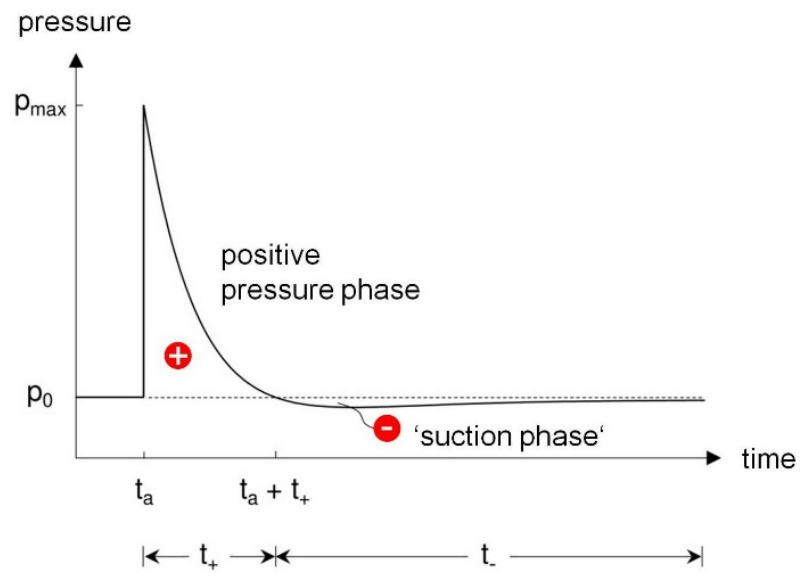
Figure 11. Temporal pressure curve (stationary) for detonation wave propagation in the free field according to the modified Friedlander equation.